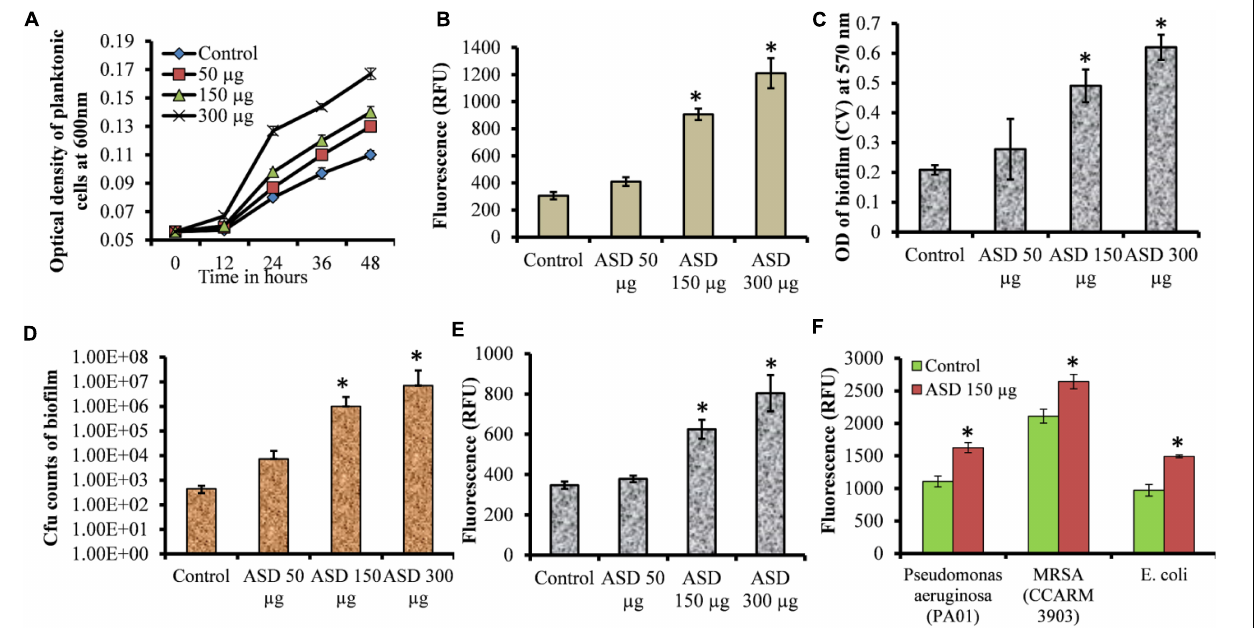
FIGURE 1 | Streptococcus pneumoniae D39 planktonic and biofilm growth in metal ion-free BHI medium. (A) Time-dependent planktonic growth from 0 to 48 h with different concentrations of ASD. Growth was detected by measuring optical density at 600 nm. (B) Planktonic growth detected by resazurin staining after 48 h incubation. (C) Quantification of in vitro biofilm biomass grown for 48 h using a CV-microplate assay. (D) Colony-forming unit (cfu) counts of in vitro biofilms grown for 48 h. (E) Quantification of in vitro biofilm growth using resazurin staining grown for 48 h. (F) Quantification of in vitro biofilm growth of Pseudomonas aeruginosa, MRSA, and E. coli grown for 48 h using resazurin staining. Error bars are the standard deviation from the mean. Statistical significance was calculated using the Student’s t -test, and P -value < 0.05 was considered significant ( ∗ P <